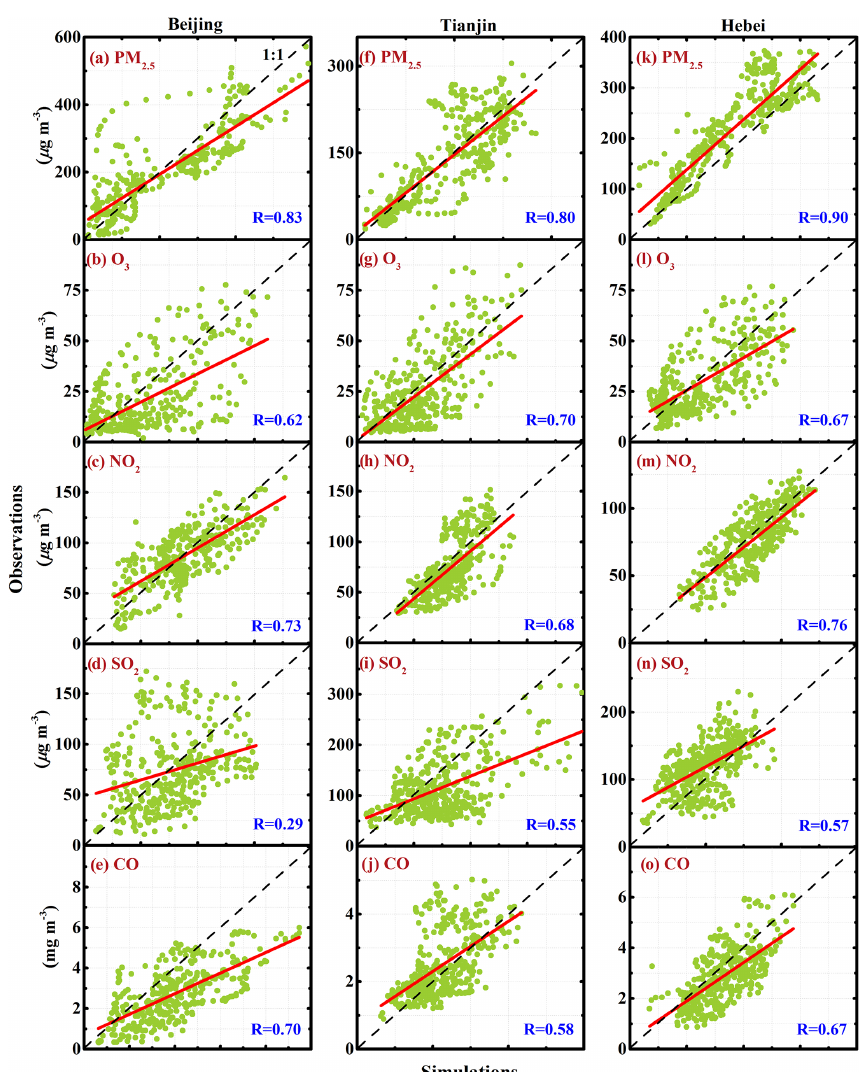
Figure 4. Relationships between observed and simulated mass concentrations of PM 2 . 5 , O 3 , NO 2 , SO 2 , and CO in Beijing, Tianjin, and Hebei from 10 to 27 February 2014. The red line is the linear regression between observations and simulations, and the black dashed line presents the 1:1